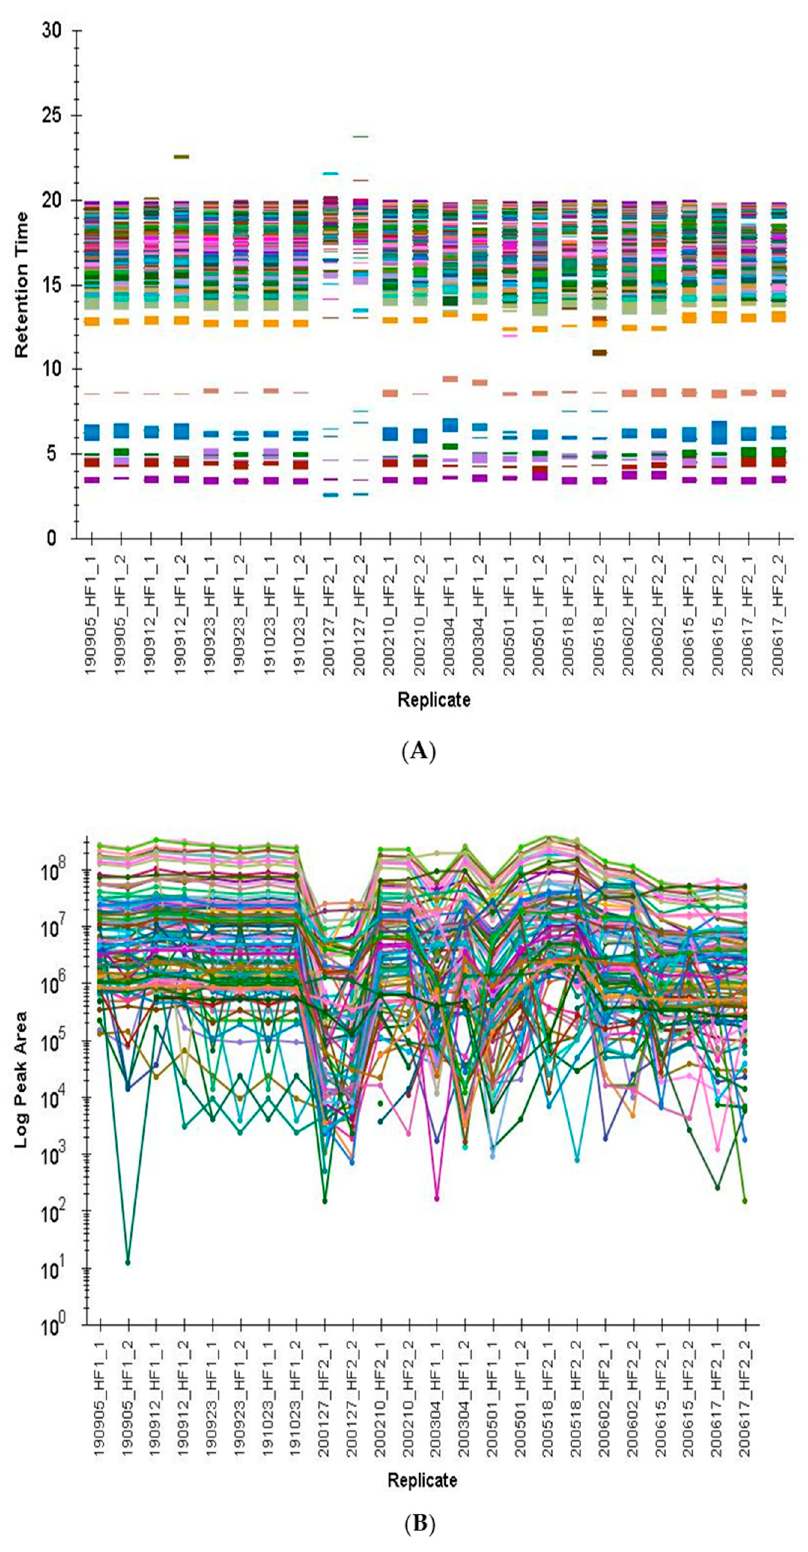
Figure 2. ( A ) Yeast extract retention time stability of the reversed-phase high-resolution mass spectrometry (RP-HRMS) targeted lipid method on two different high-resolution mass spectrometers (Orbitrap HF 1, HF 2) over the time course of 10 months using Skyline for visualization [51]. ( B ) Yeast extract control of 26 lipids using RP-HRMS to monitor the performance of two Orbitrap mass analyzers (HF 1, HF 2) using Skyline for visualization [51].